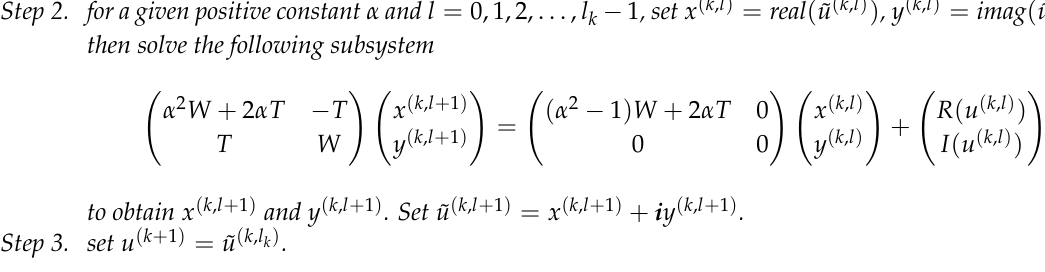
Algorithm 2 (The C-to-R-based Picard iteration method) . Let φ ⊂ C n → C n be a continuously differentiable function and A = W + i T ∈ C n × n be a large, sparse complex symmetric matrix, where W ∈ R n × n and T ∈ R n × n are the real parts and the imaginary parts of A, respectively. Given an initial guess u ( 0 ) ∈ C n . For k = 0, 1, 2, · · · , until { u ( k ) } converges, compute the next iterate { u ( k + 1 ) } according to the following steps.